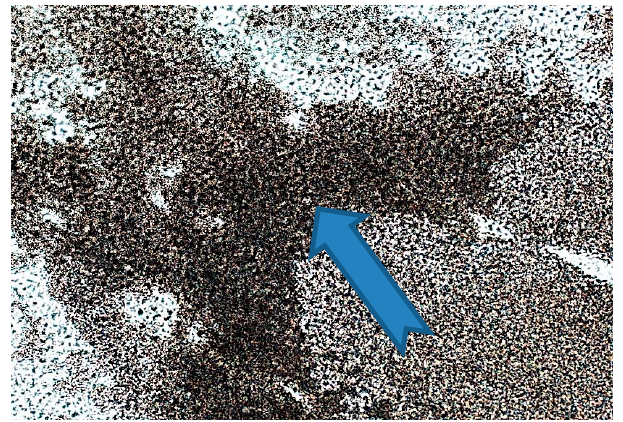
Figure 10. The inner surface of the “old” film with betulin diffused from the polymer is a dark zone. 20× magnification.